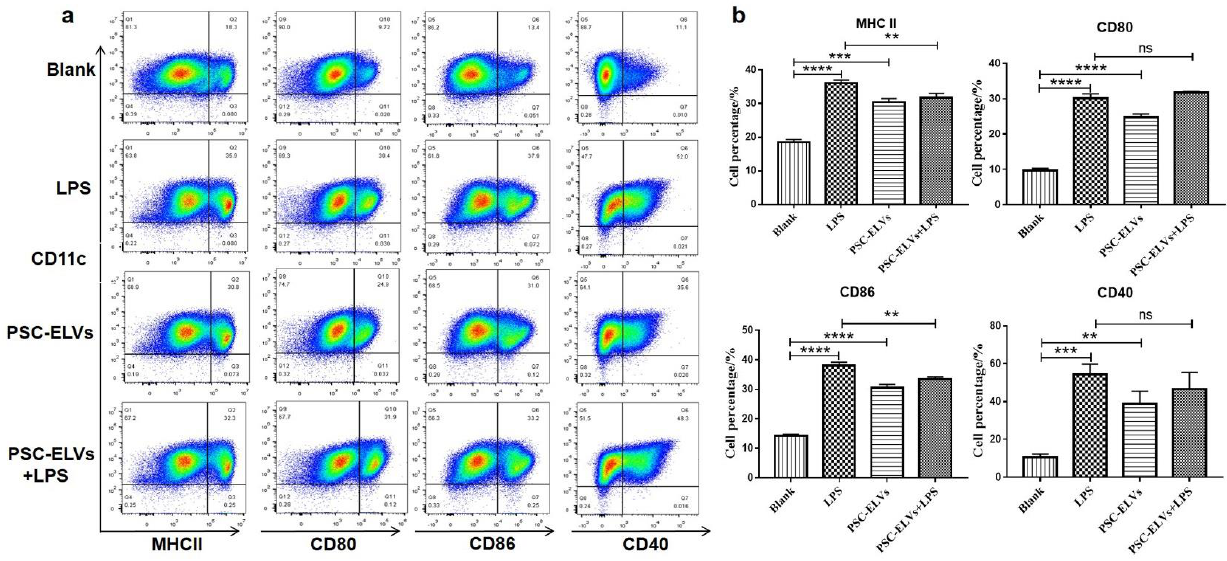
Figure 5. The changes in the expressions of major histocompatibility complex class II (MHC II), CD40, CD80, and CD86 on the surface of BMDCs stimulated with PSC-ELVs, as detected using flow cytometry. ( a ) Pseudocolor diagrams of the BMDCs surface markers; ( b ) Statistical analysis of the proportions of BMDCs surface molecules, ** p < 0.01; *** p < 0.001; **** p < 0.0001; ns, not significant.